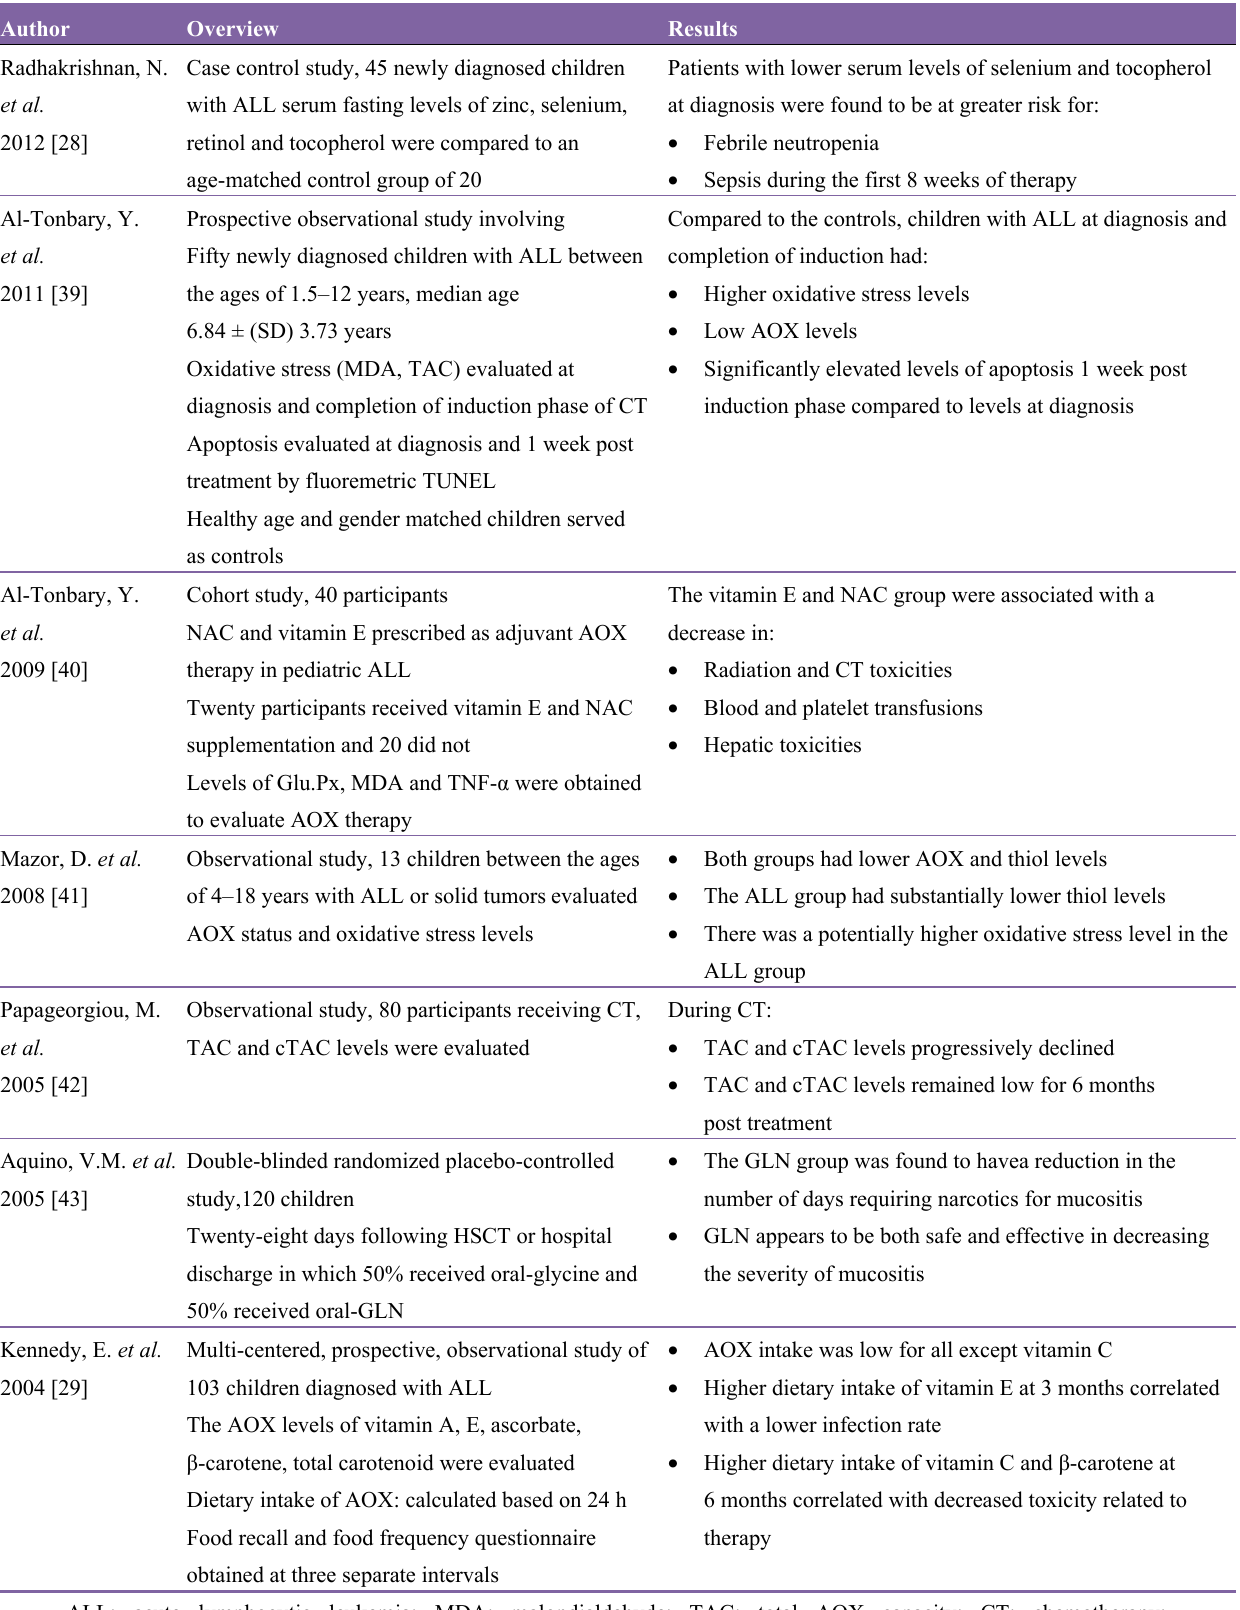
Table 3. Overview of nutrition related pediatric oncology